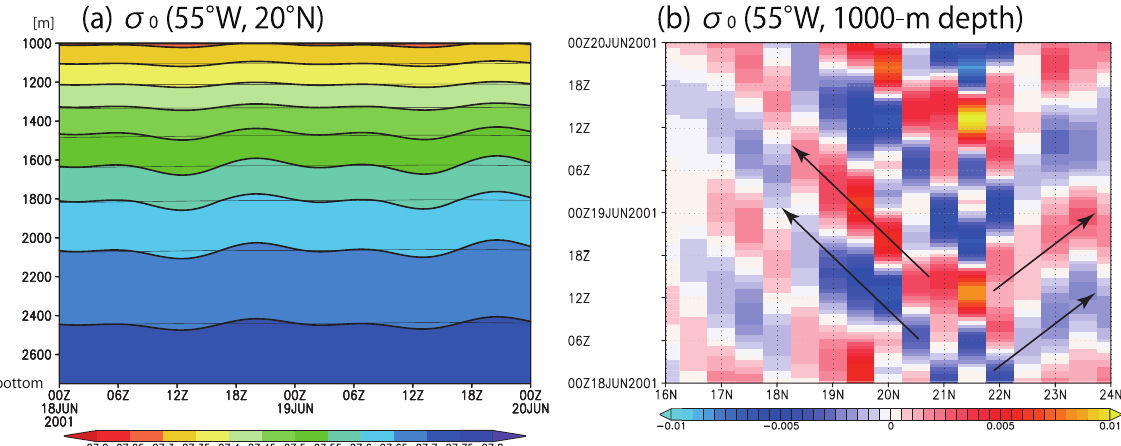
Fig. 11. (a) Vertical distribution of potential density σ 0 (kgm − 3 ) from bottom to the 1000 m depth at (55 ◦ W, 20 ◦ N) for 18–20 June 2001 (day 39–40) of TIDE (thick lines and colored shading) and NOTIDE (thin lines). (b) Hovmöller diagram of potential density anomaly σ 0 55 ◦ W, 1000-m depth in TIDE. The meridional range is 16–24 ◦ N, and the time period is the same as (a) . The arrows indicate propagation of internal tides.